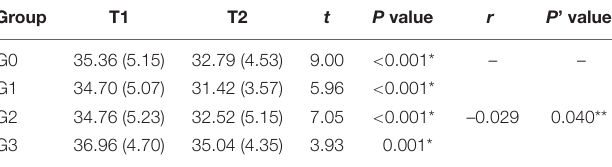
TABLE 2 | Comparison of T1 and T2 scores on the China Developmental Scale for Children in the intervention group.